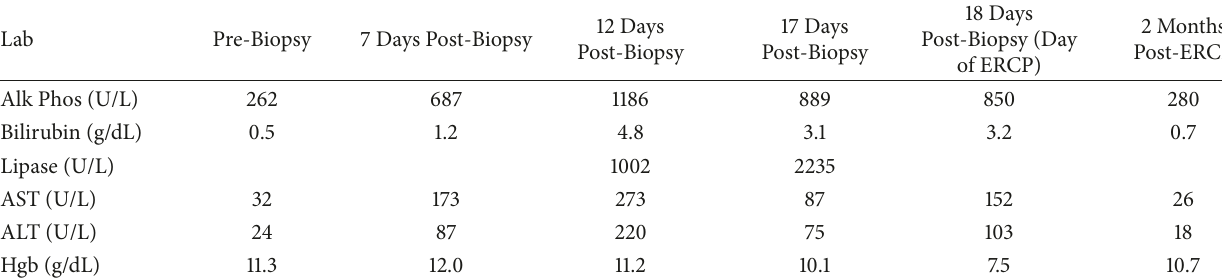
Table 1: Laboratory values before and after biopsy and ERCP.